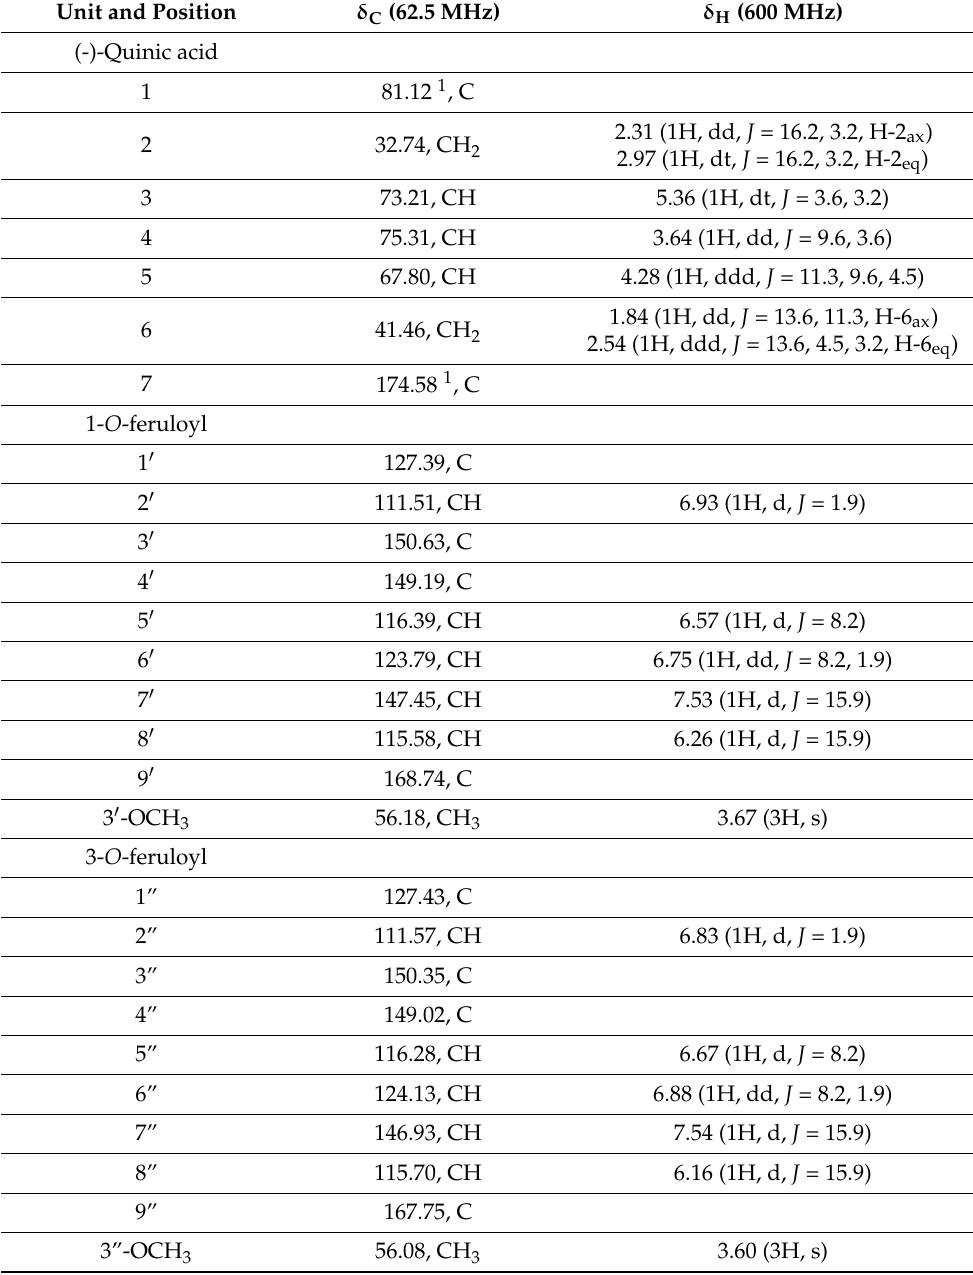
Table 3. NMR data of 1,3-di- O - trans -feruloyl-( − )-quinic acid ( 1 ) in CD 3 OD. Unit and